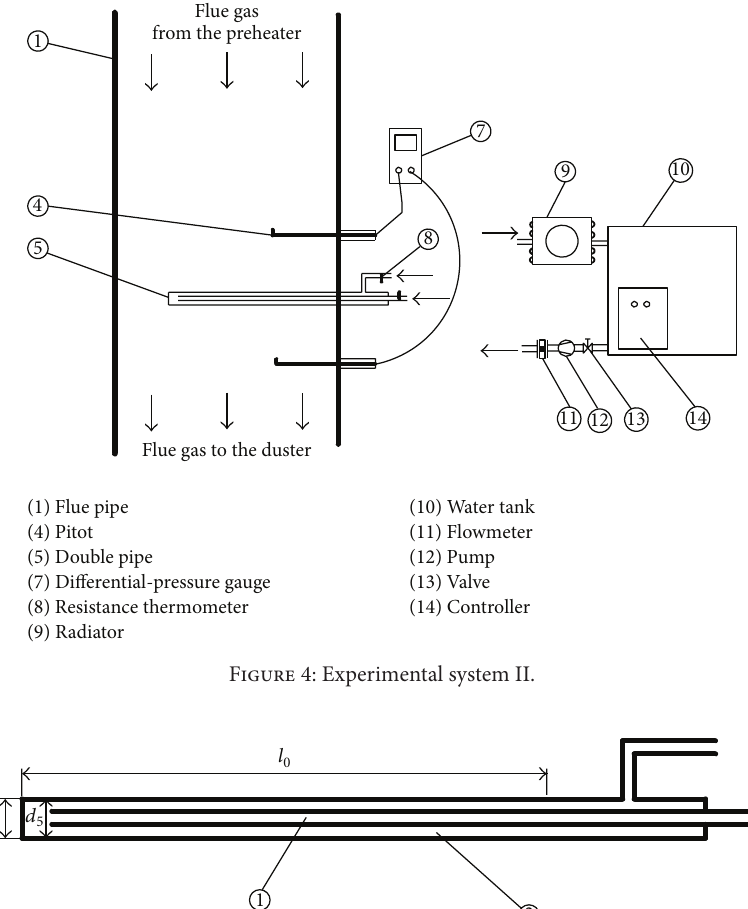
Figure 5: Geometrical sketch of the double pipe of experiment II.